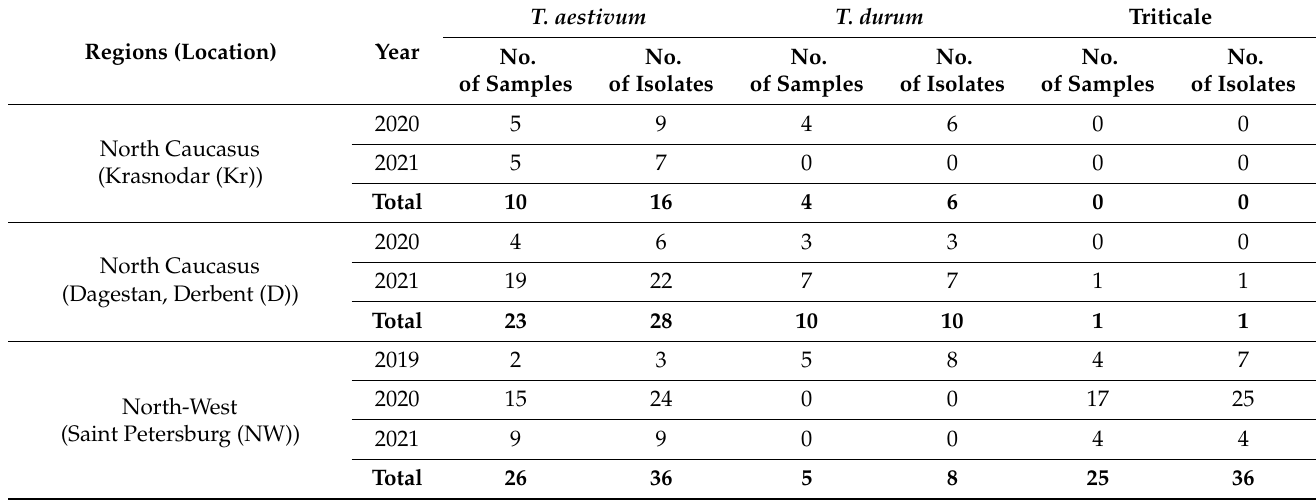
Table 5. Sampling details of isolates in regional collections of P. striiformis . T. aestivum T. Regions (Location) Year